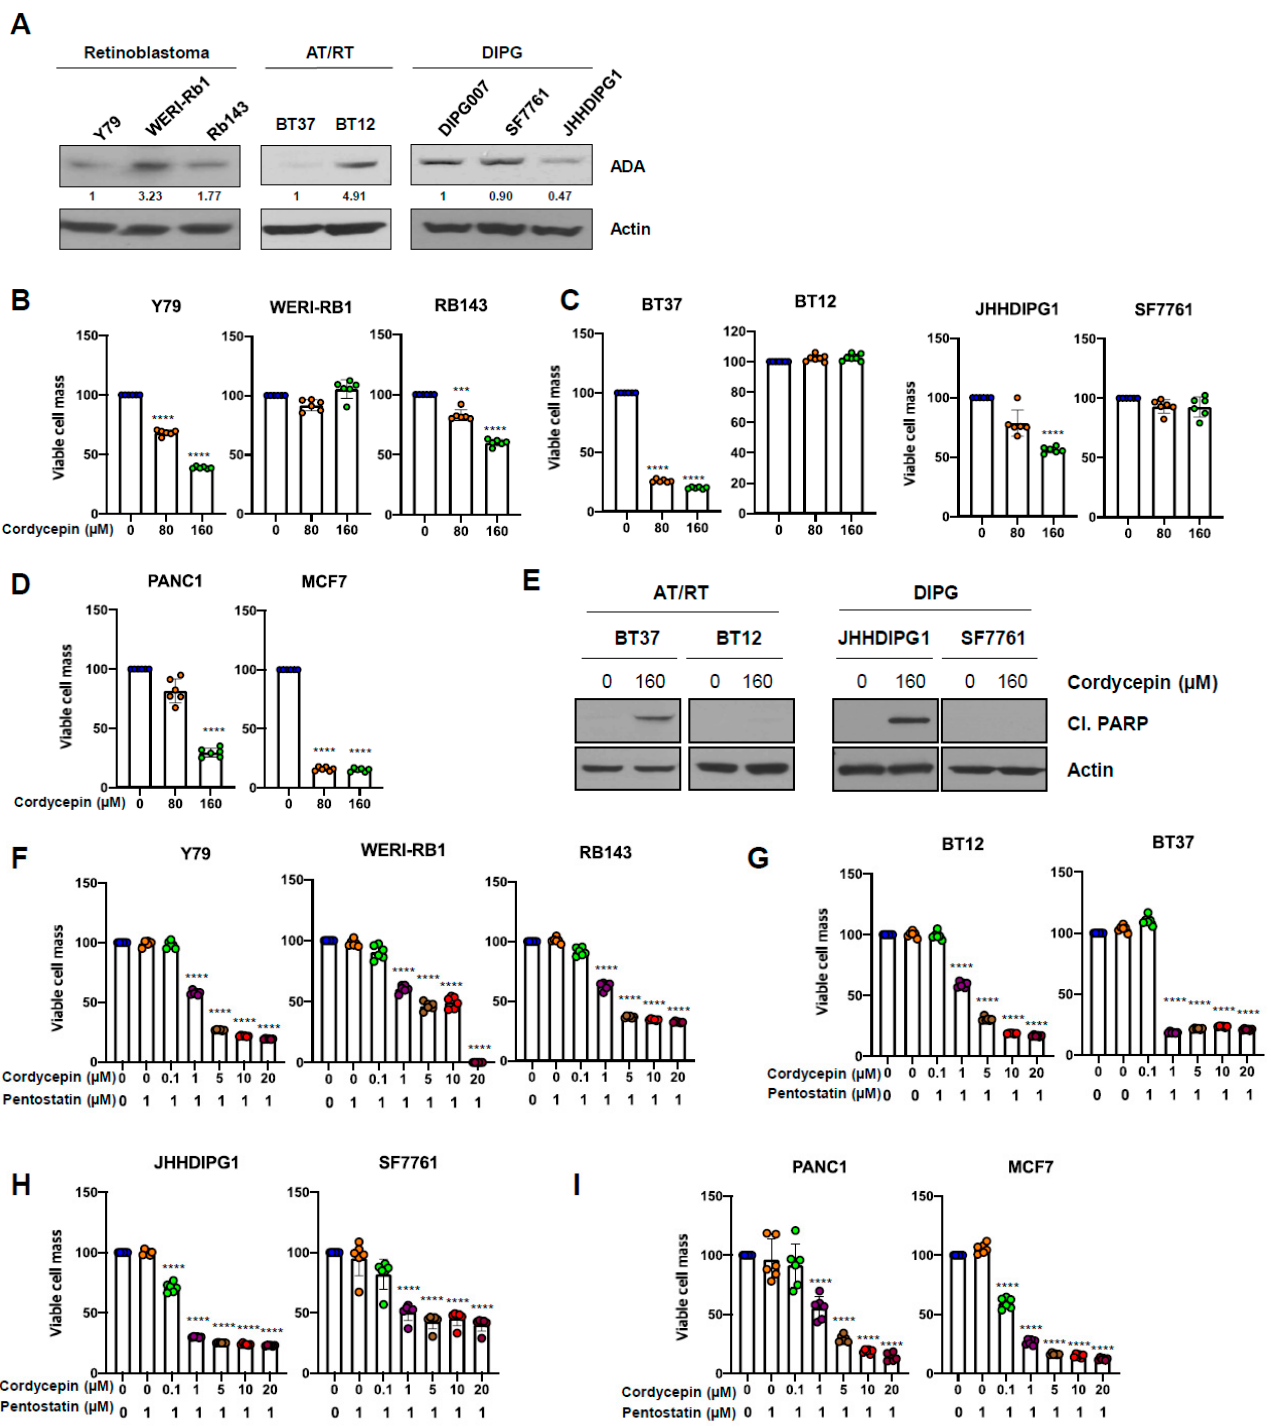
Figure 6. Anticancer effects of cordycepin in other aggressive cancer cells. ( A ) ADA protein expression levels were measured by Western blot in retinoblastoma, AT/RT, and DIPG cell lines. ( B – D ) Cells were treated with for 5 days and then cell titer blue was used to measure viable cells. ( E ) Cells were treated with cordycepin for 2 days, and then cleaved PARP protein level was evaluated by Western blot. ( F – I ) Cells were treated with cordycepin and 1 μ M of pentostatin for 5 days and then cell titer blue was used to measure viable cells. Values represent mean ± SD of experiments conducted in sextuplicate. *** p < 0.001, **** p < 0.0001 by one-way ANOVA analysis of variance compared with control group.